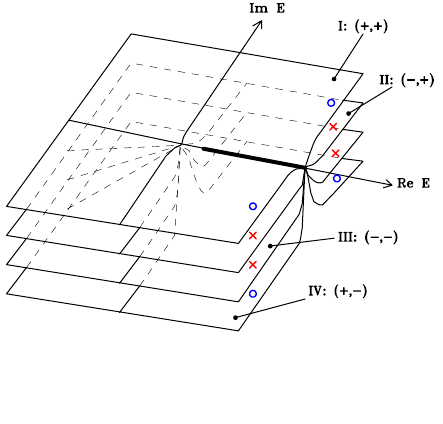
Figure 2. Riemann sheets for two channels with poles (crosses) and zeroes (circles) for one